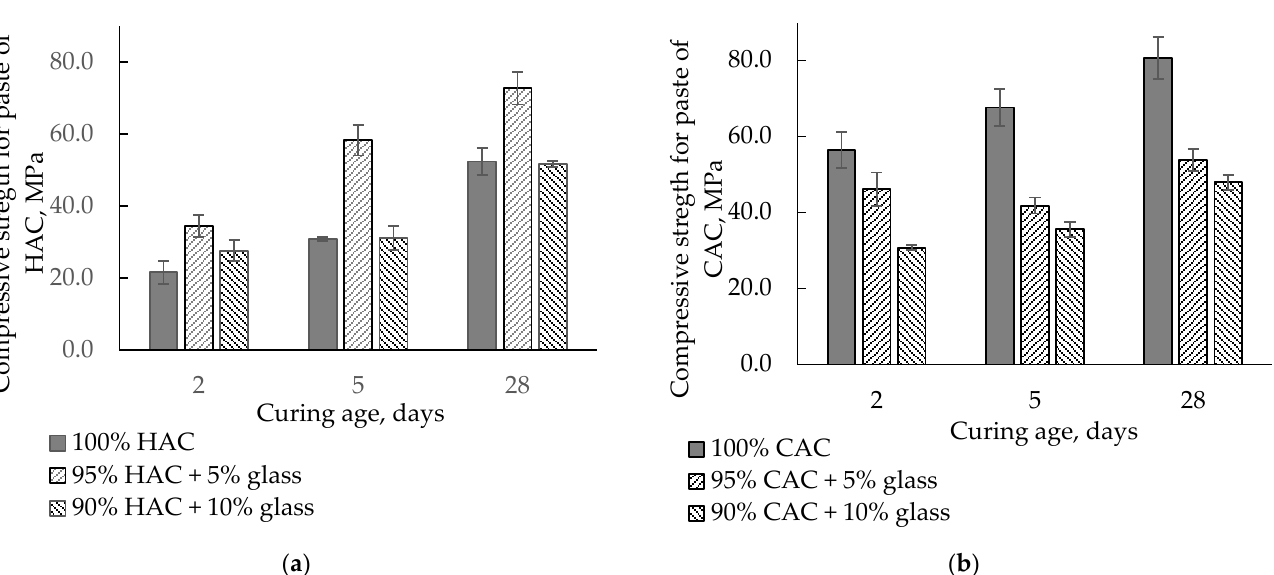
Figure 6. The compressive strength for the paste of HAC and CAC with glass stored at 20 °C. ( a ) HAC-glass systems; ( b ) CAC-glass systems.